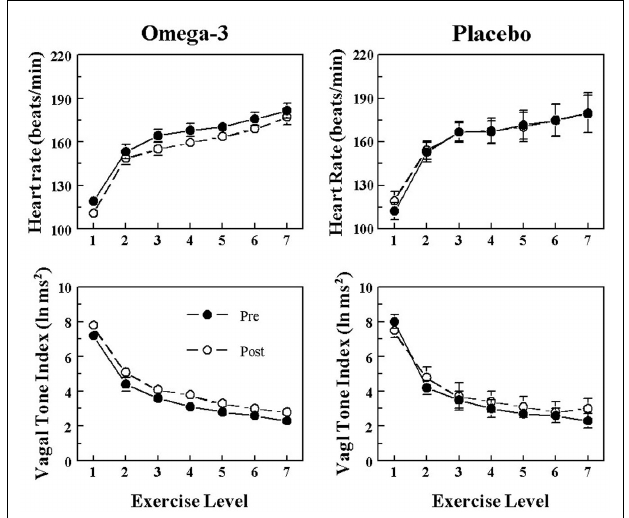
FIGURE 4 | Effect of omega-3 polyunsaturated fatty acids (n − 3 PUFAs) on the heart rate and heart rate variability response to submaximal exercise in dogs resistant to ventricular fibrillation. Dietary n − 3 PUFA, but not the placebo, produced a significant downward shift of the heart rate (HR) response curve that was accompanied by an upward shift in the high frequency (HF) component of the R–R interval variability (vagal tone index 0.24–1.04Hz; i.e., significant pre–post effect: HR, P < 0.05; HF, P < 0.02). Despite the shifts in the curves, the absolute change in these variables induced by the exercise was not altered before or after the treatment (i.e., there were no significant pre–post-treatment × exercise interactions: HR, P = 0.67; HF, P = 0.88).The data were averaged over the last 30s of given exercise level. Exercise levels are as follows: 1 = 0kph and 0% grade; 2 = 4.8kph and 0% grade; 3 = 6.4kph and 0% grade; 4 = 6.4kph and 4% grade; 5 = 6.4kph and 8% grade; 6 = 6.4kph and 12% grade; 7 = 6.4kph and 16% grade. Pre = before placebo ( n = 8) or n − 3 PUFA (1–4g/day, n = 23) treatment began, post = after 3months of